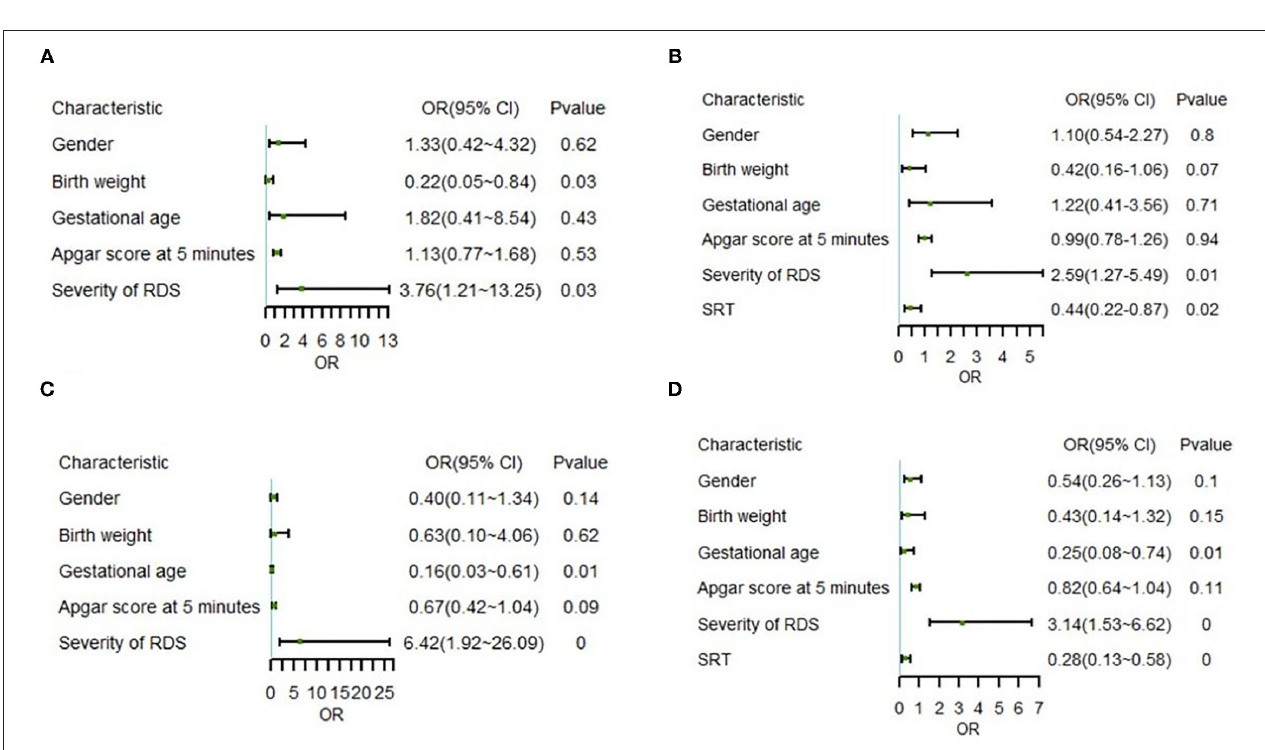
FIGURE 4 | Correlation between various indicators and outcomes in multivariate logistic regression. (A) Model I for non-SRT samples in the high-altitude group, (B) Model II for whole samples in the high-altitude group, (C) Model III for non-SRT samples in the ultra-high-altitude group, and (D) Model IV for whole samples in the ultra-high-altitude group. OR, odds ratio; 95% CI, 95% confidence interval; RDS, respiratory distress syndrome; SRT, surfactant replacement therapy. 0 represents P < 0.01.